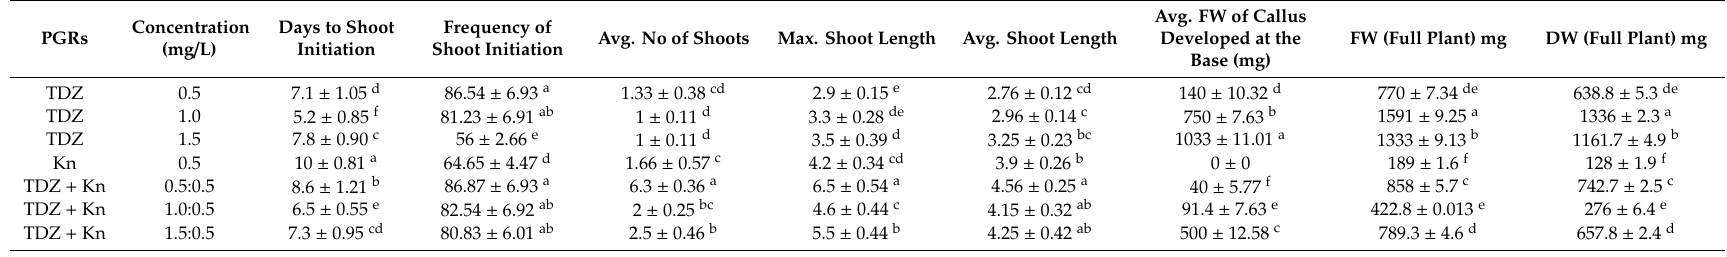
Table 2. Optimization of shoot organogenesis in L. usitatissimum . Values represent mean data of each treatment with ± standard error. Data was collected after four weeks culture period. Data with di ff erent letter(s) is statistically significant at p ≤ 0.5. TDZ: thidiazuron, Kn: Kinetin, DW: Dry weight, and FW: Fresh